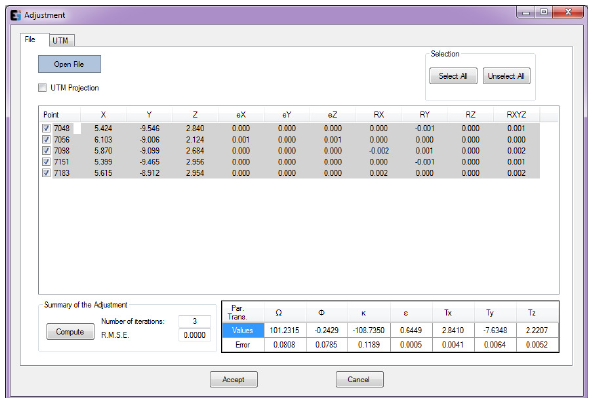
Figure 6. Results of the 3D transformation adjustment in